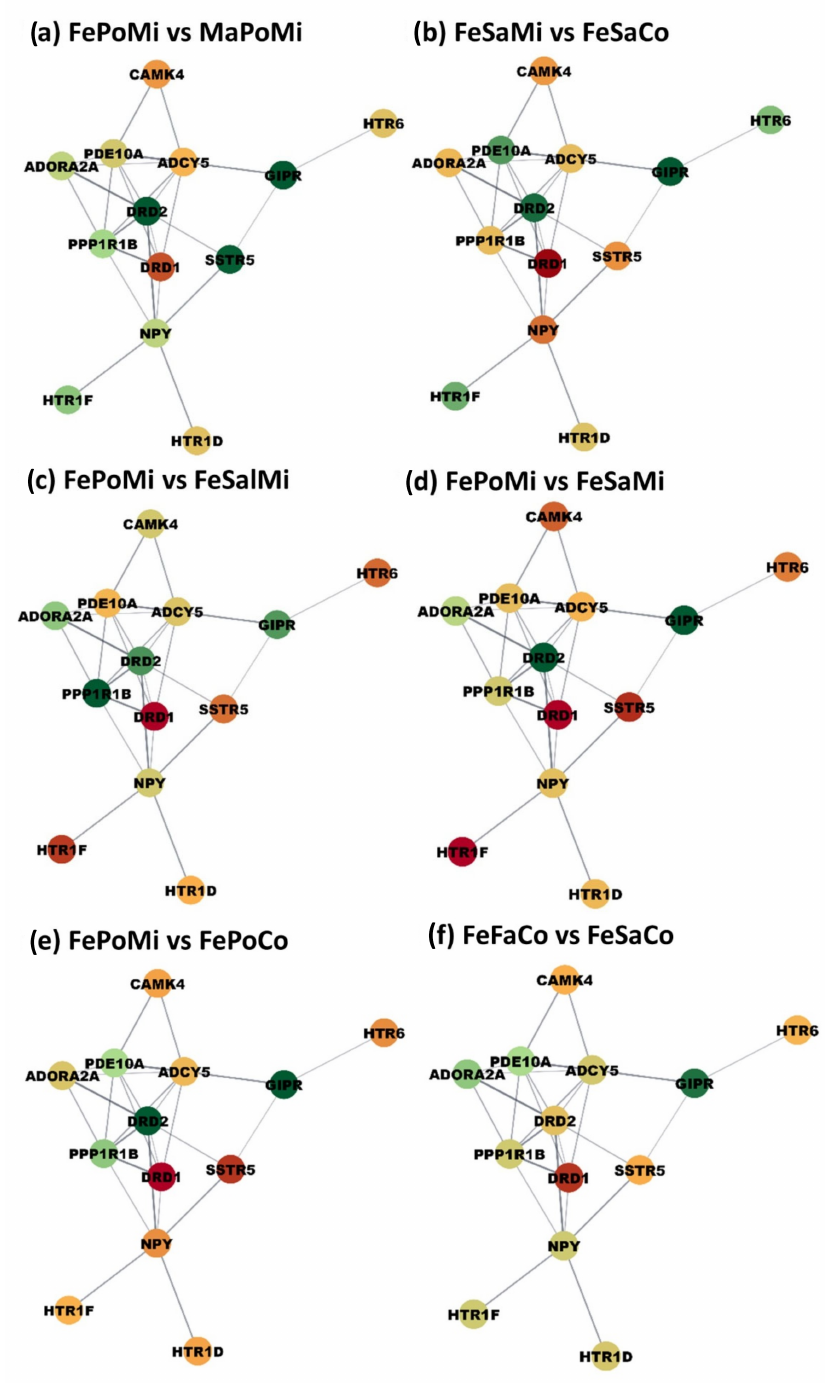
Figure 2. Gene networks for the cAMP signaling showcasing group contrasts presenting a wide range of gene expression changes across the network. Nodes represent the genes; edges represent STRING database connections confirmed by the study; node color represents differential expression between groups. The first letters of the contrasts label denote the sex (Ma = male vs. Fe = female), followed by the postnatal stressor (Sa = saline vs. Po = Poly(I:C) vs. Fa = fasting), and the ending letters denote the maternal immune activation group (Co = non-MIA controls vs. Mi = MIA PRRSV-exposed animals). Colors range from red (under-expression in the first group vs. the second group) to yellow (neutral fold change value) to green (over-expressed in the first group vs. the second